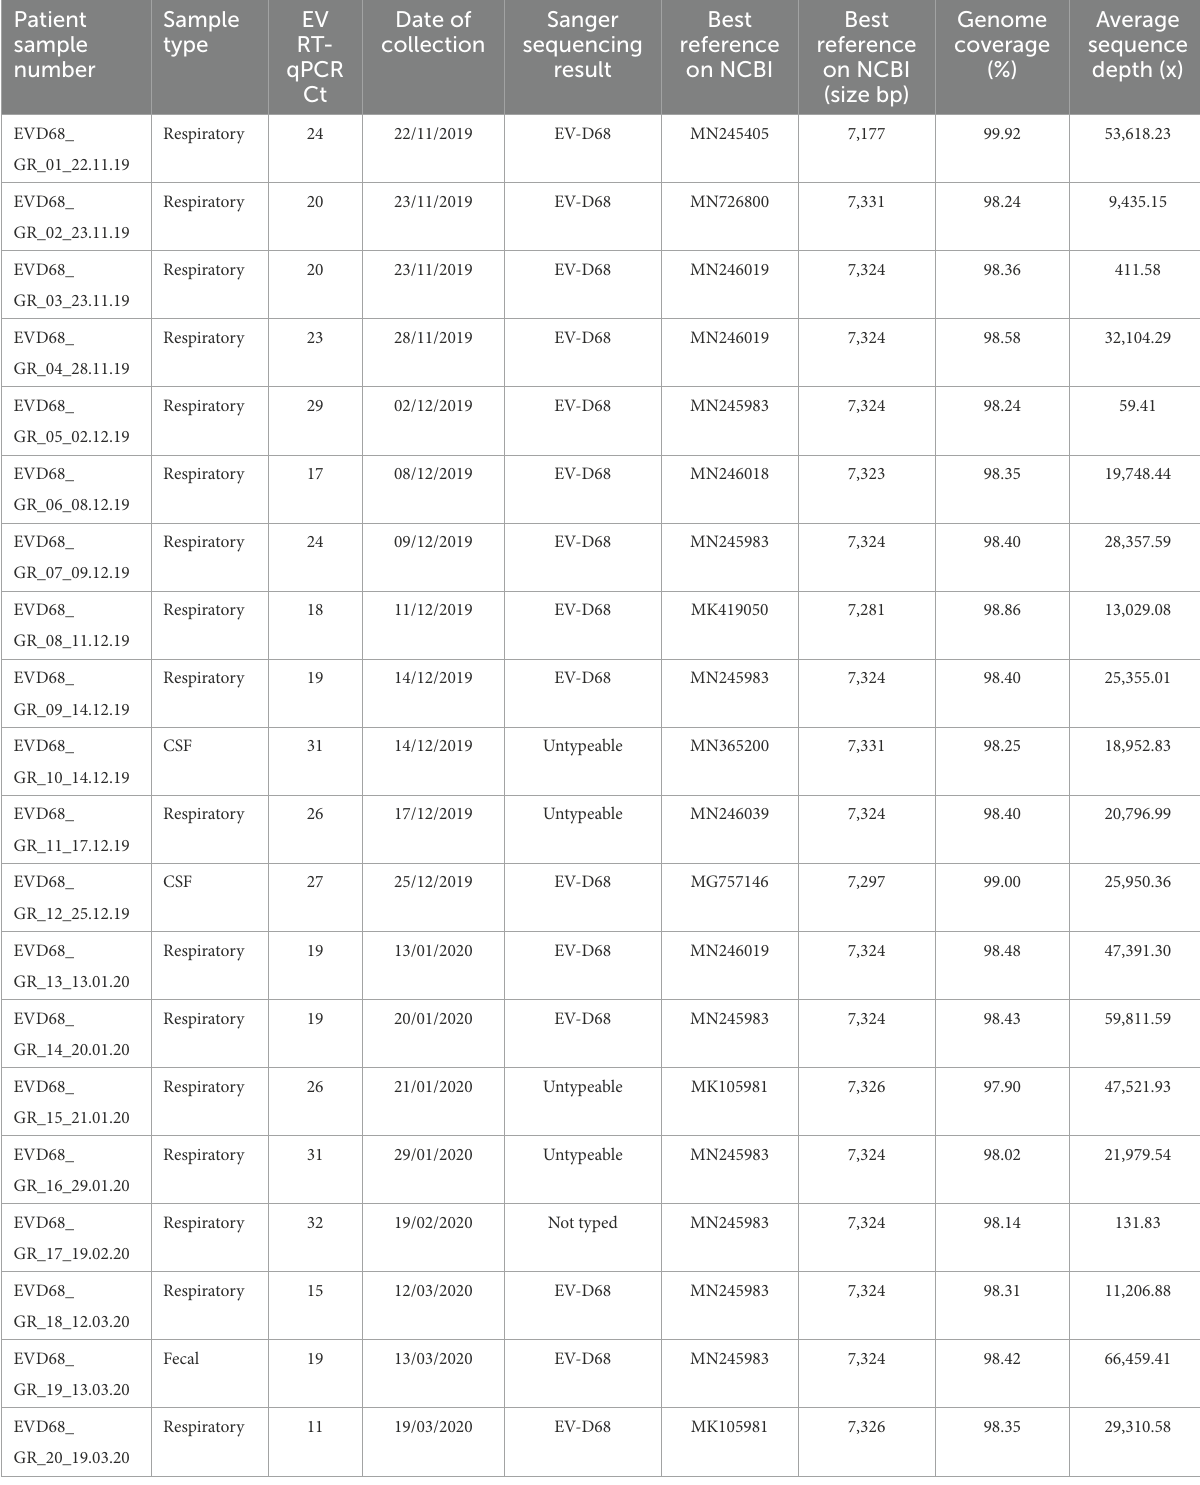
TABLE 2 Metatable of sample